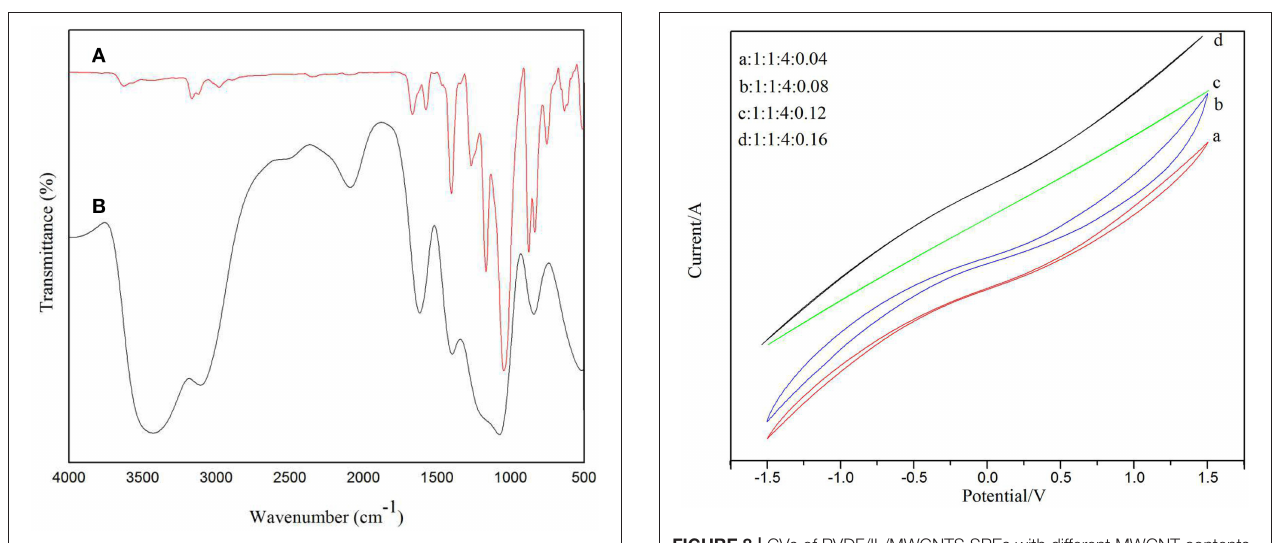
FIGURE 7 | FTIR spectra of (A) solid electrolyte doped with carbon nanotubes and (B) solid electrolyte without carbon nanotubes.